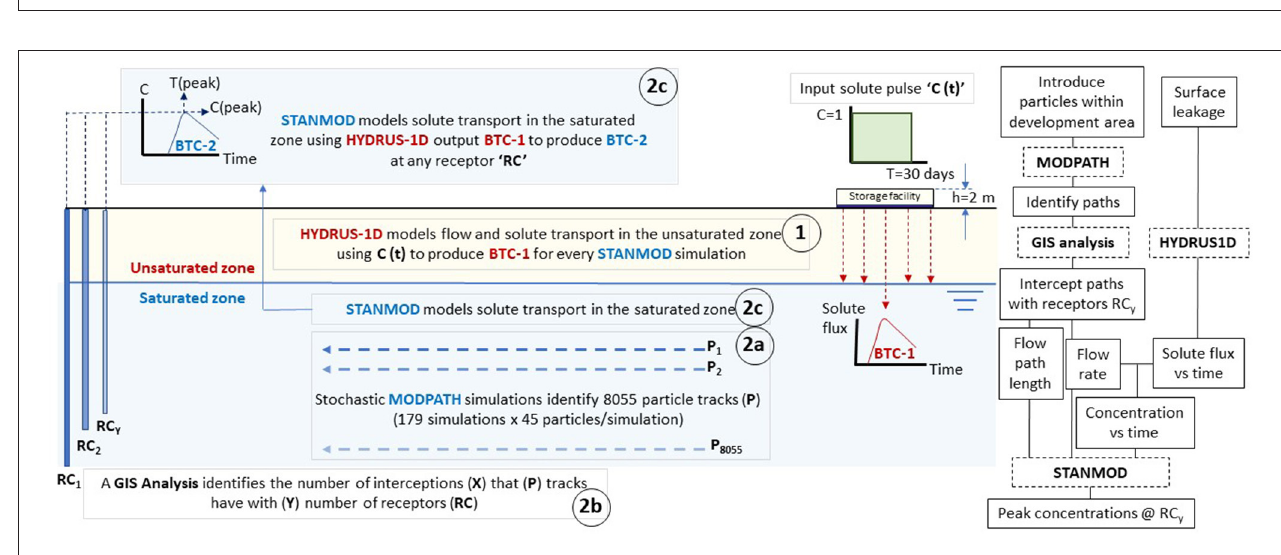
FIGURE 2 | Conceptual diagram of proposed hybrid modelling approach.